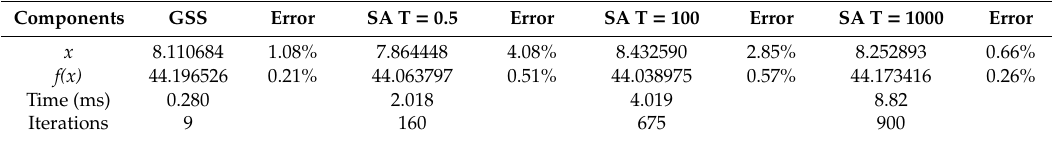
Table 6. Results of the algorithms for the test function